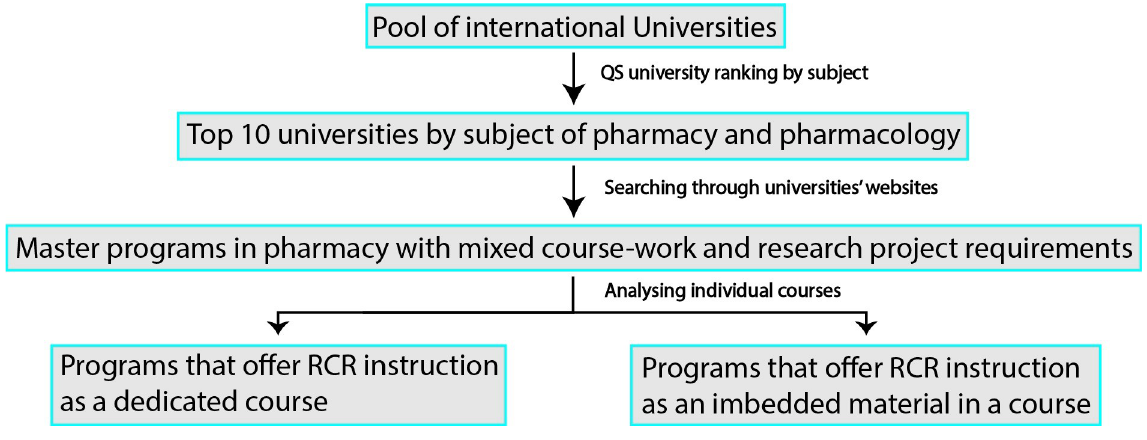
Fig 2. Stepwise data collection approach from top 10 universities